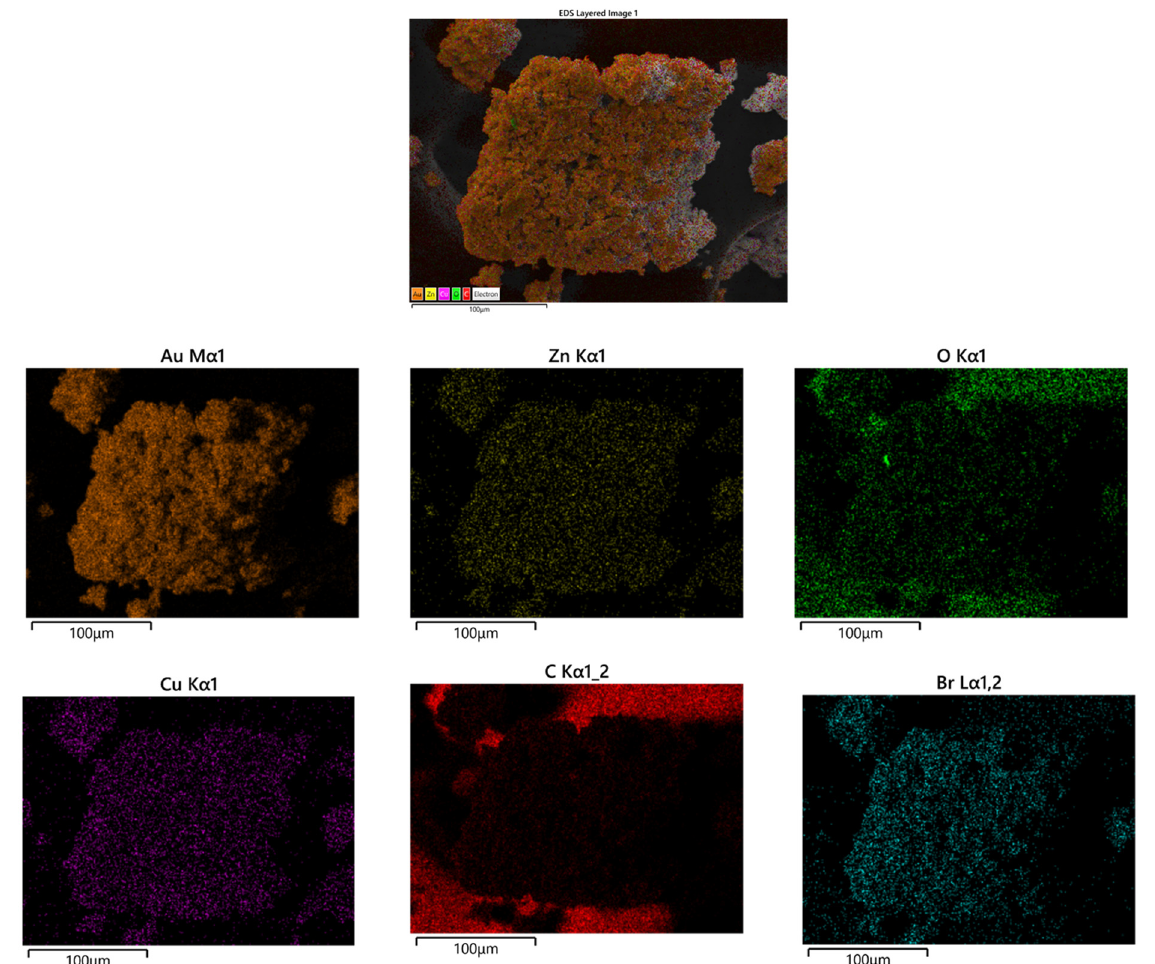
Figure 12. EDS (SEM) analysis of the produced gold powder.